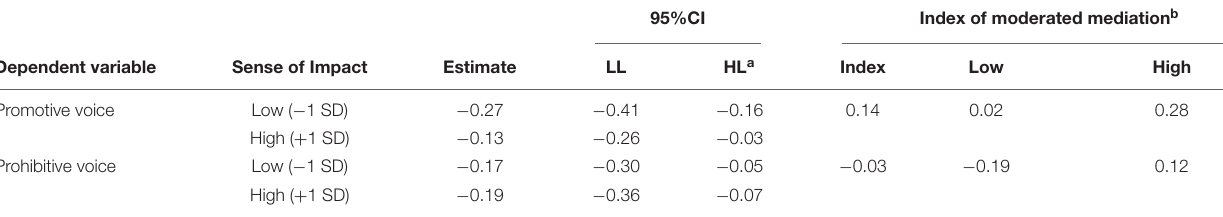
TABLE 3 | Results of conditional indirect effect